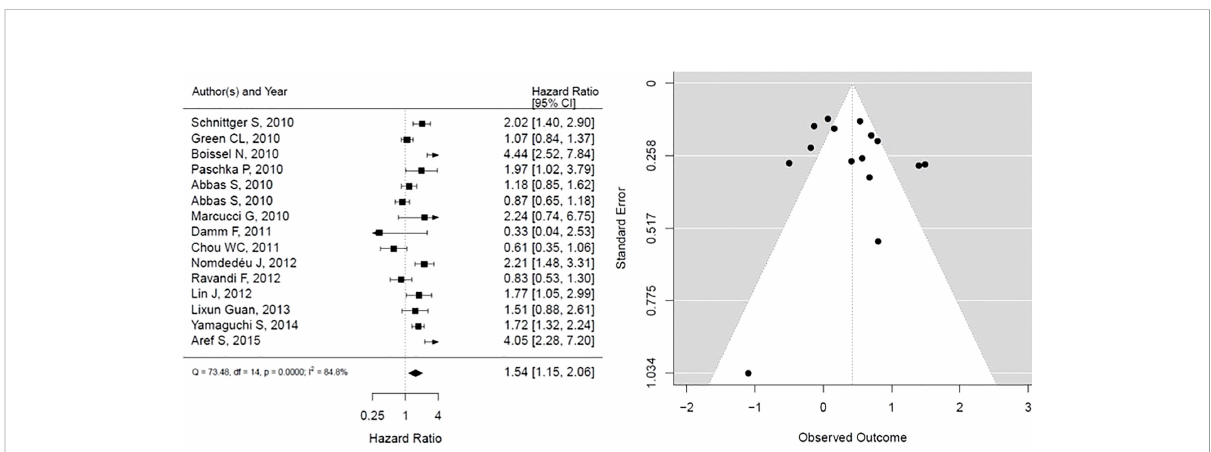
FIGURE 5 Forest plot and funnel plot of the HR for overall survival in IDH mutation. The fi rst author and year of publication is provided for each study. The hazards ratio (boxes) with 95% con fi dence intervals (CI, horizontal lines) were calculated, the pooled hazards ratio (diamond) was estimated using random effect model. The P value for comparing heterogeneity between subgroups was calculated using I-squared. IDH, Isocitrate